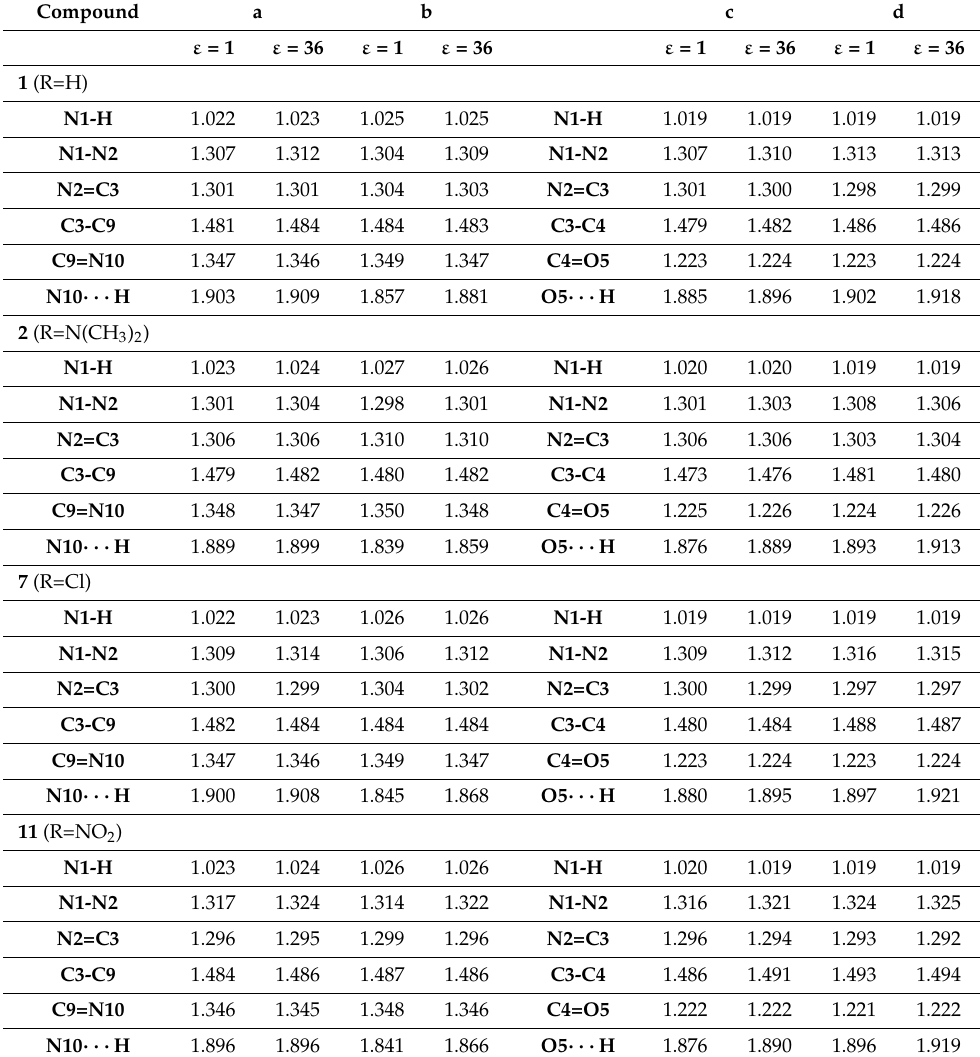
Table 3. Selected bond lengths and distances (in Å) calculated at M062X/6-31+G(d,p) level of theory for a – d isomers of compounds 1 , 2 , 7 and 11 in the gas phase and acetonitrile solution. Atom numbering scheme is shown in Figure 1 and Table